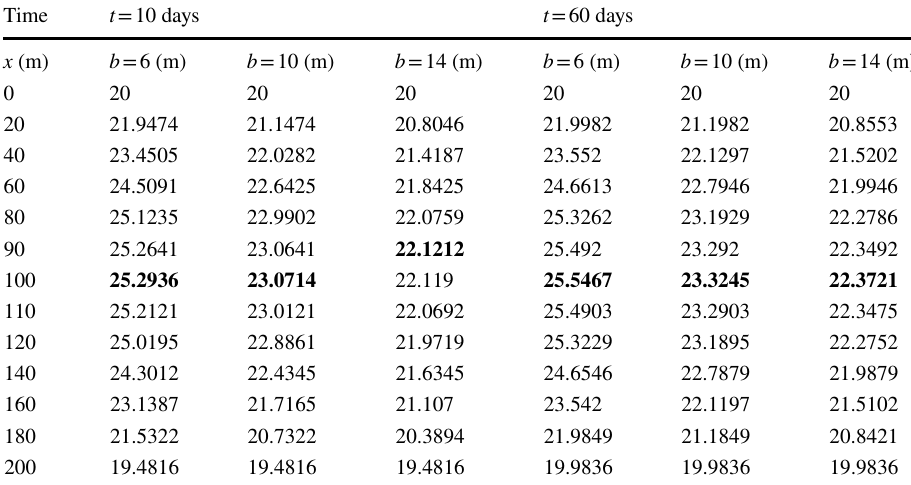
Table 4 The effect of variation in recharge rate ( w ) on the groundwater hydraulic head at t = 10 days and t = 60